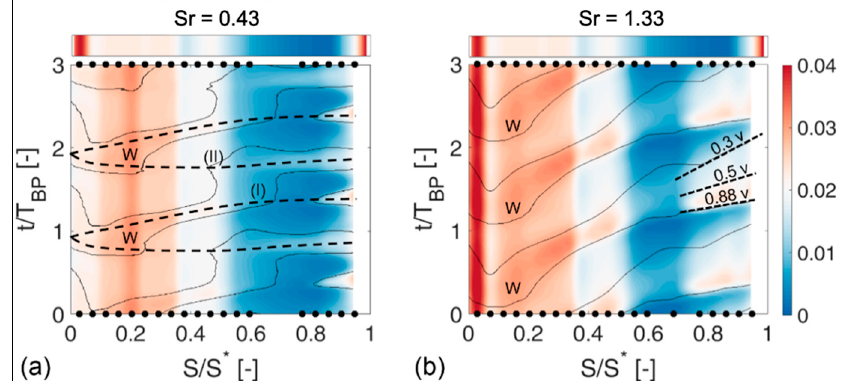
Figure 31. Temporal evolution of QWSS along the T106 RUB profile suction side at midspan for Sr = 0.43 ( a ) and Sr = 1.33 ( b ), undisturbed condition shown above, see [58].